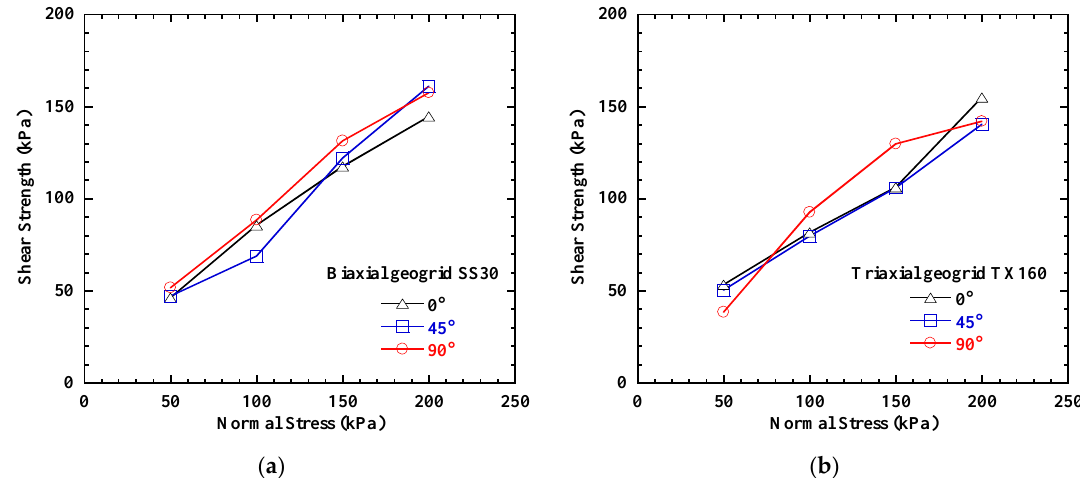
Figure 6. Strength envelopes for fine sand–biaxial geogrid (SS30) interfaces and fine sand–triaxial geogrid (TX160) interfaces. ( a ) SS30, ( b ) TX160.